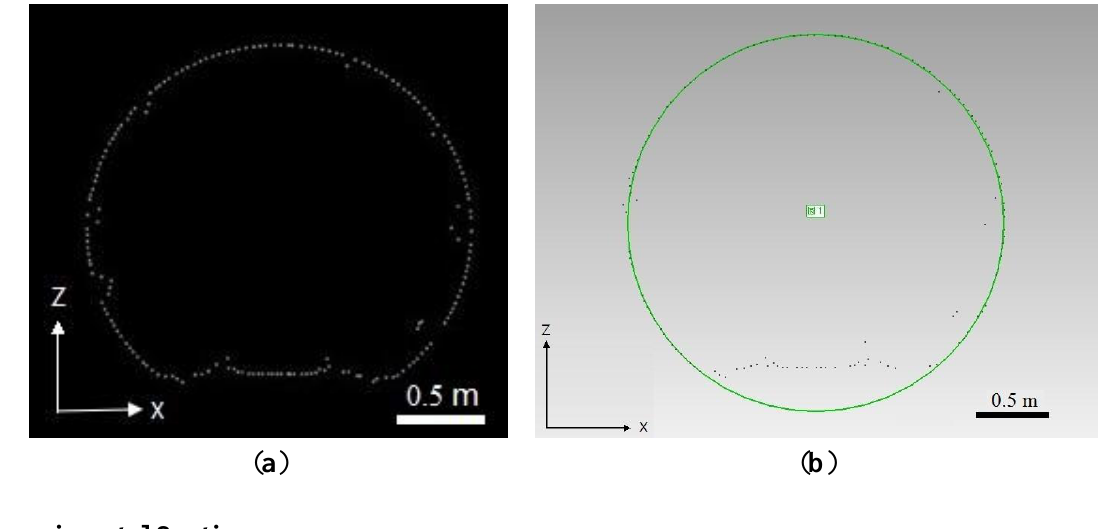
Figure 7. Extraction of the cross section. ( a ) Extracted cross-sectional points; ( b ) The real cross-sectional points.